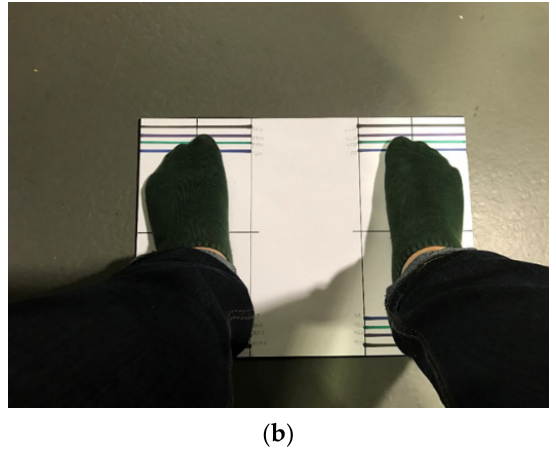
Figure 2. ( a ) The simple architecture prototype used for standing and measuring bodyweight load distribution on both feet: (1) inter-plate connection; (2) area of the platform that corresponds to the right forefoot that corresponds to pressure sensor cells; (3) electronics; (4) area of the platform that corresponds to the right rearfoot that corresponds to pressure sensor cells; (5) electronics; (6) area of the platform that corresponds to the left rearfoot that corresponds to pressure sensor cells; (7) area of the platform that corresponds to the left forefoot that corresponds to pressure sensor cells; (8) electronics; and ( b ) the testing process that starts with the user checking their feet size using the measuring template on the plate.